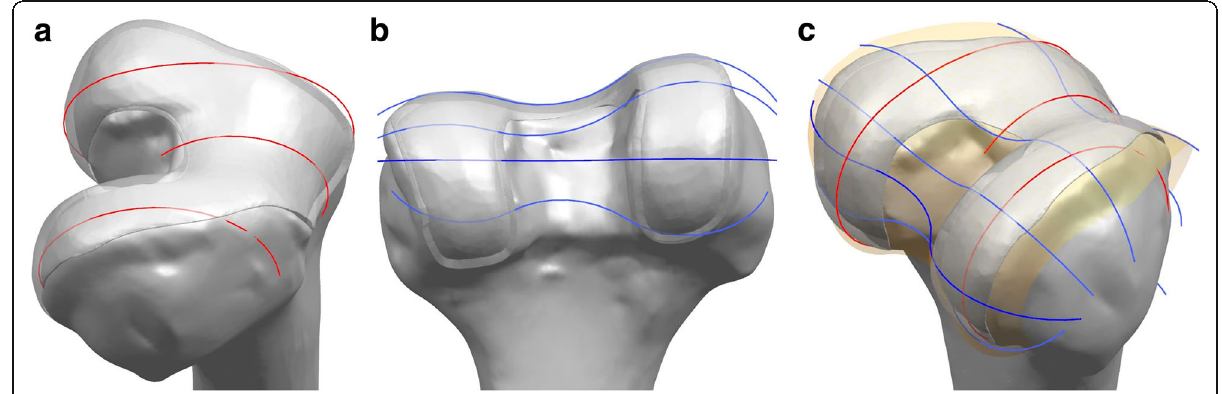
Fig. 3 Development of customized femoral component: ( a ) three patient-specific “ J ” curves in sagittal planes; ( b ) patient ’ s anatomic curves in coronal planes; ( c ) surface geometry for femoral component using the articulating